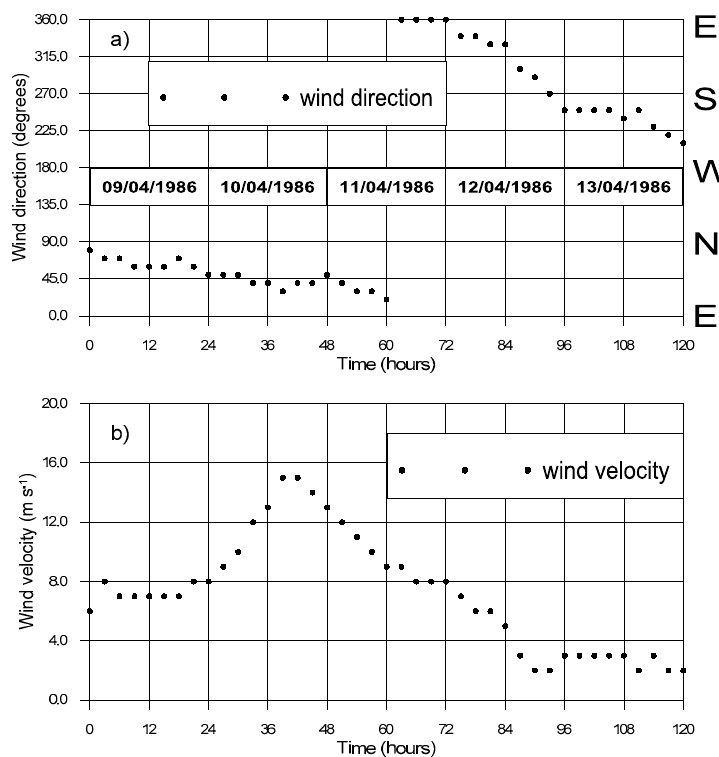
Figure 16. Wind parameters observed at Nowa Pas łę ka (9 April–13 April 1986), ( a ) direction, ( b ) velocity.